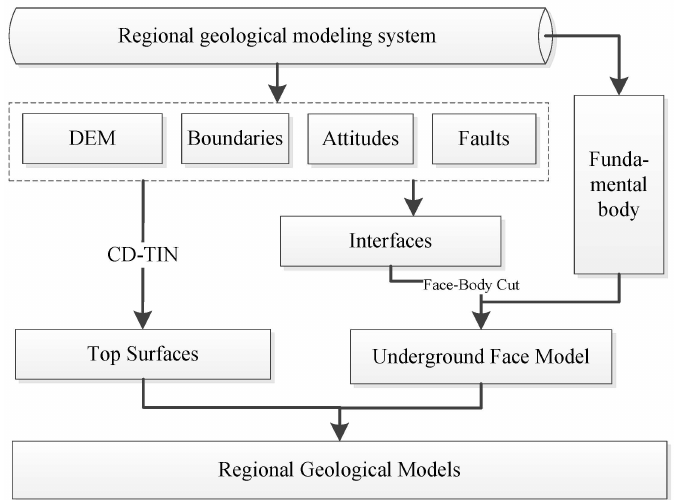
Figure 1. Modeling